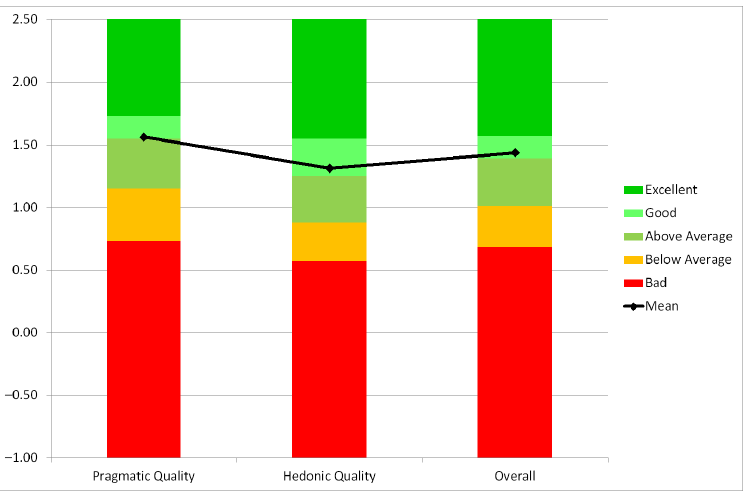
Figure 13. UEQ Benchmark in SAR